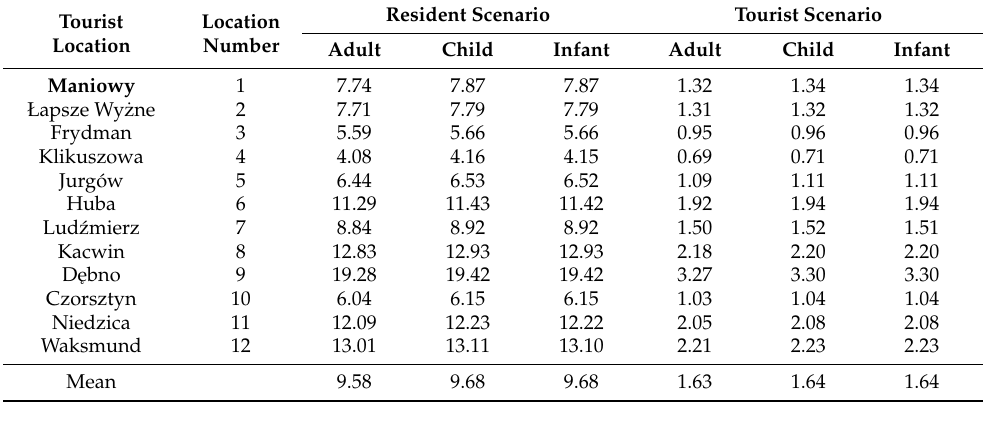
Table 2. Total non-carcinogenic risk values in the study areas.